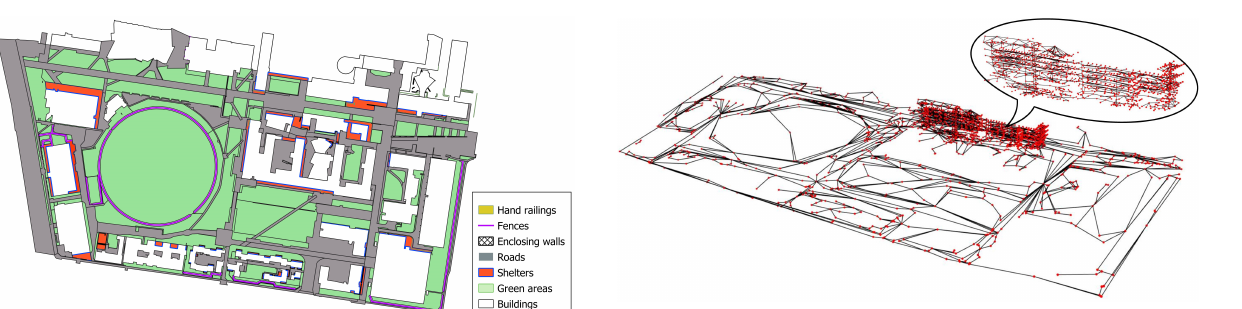
Figure 8. Selected area of university campus for testing.